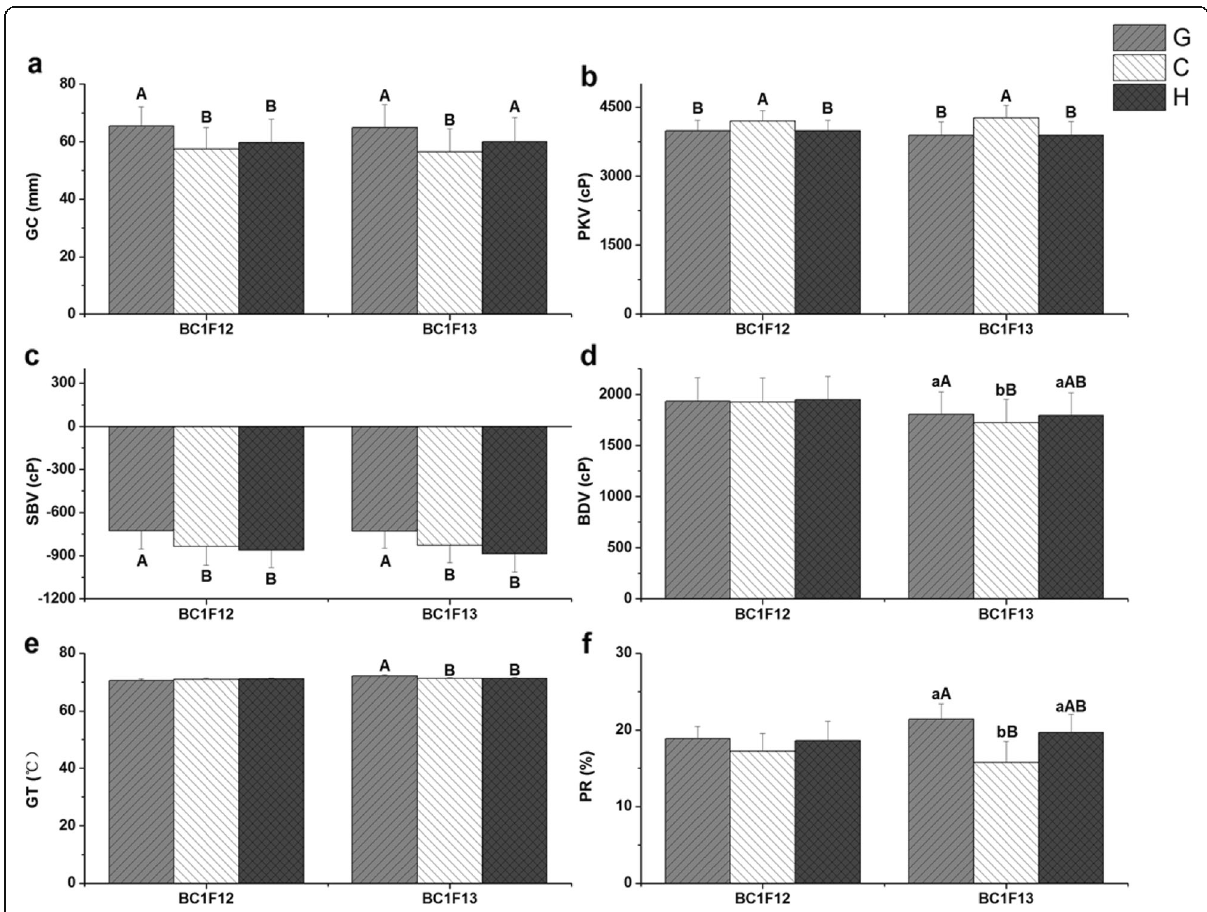
Fig. 3 Comparison of starch physicochemical properties among different SSIV-2 genotypes in BC 1 F 12 and BC 1 F 13 generation. a Gel consistency (GC); b Peak viscosity (PKV); c Setback viscosity (SBV); d Breakdown viscosity (BDV); e Gelatinization temperature (GT); f Percent of retrogradation (PR). Each column represents the mean ± standard deviation. Lowercase and capital letters above column denote significant at 0.05 and 0.01 levels, respectively. G denotes homozygous for GZ63S, C and H denotes homozygous for CG173R and heterozygote, respectively. Each sample was repeated